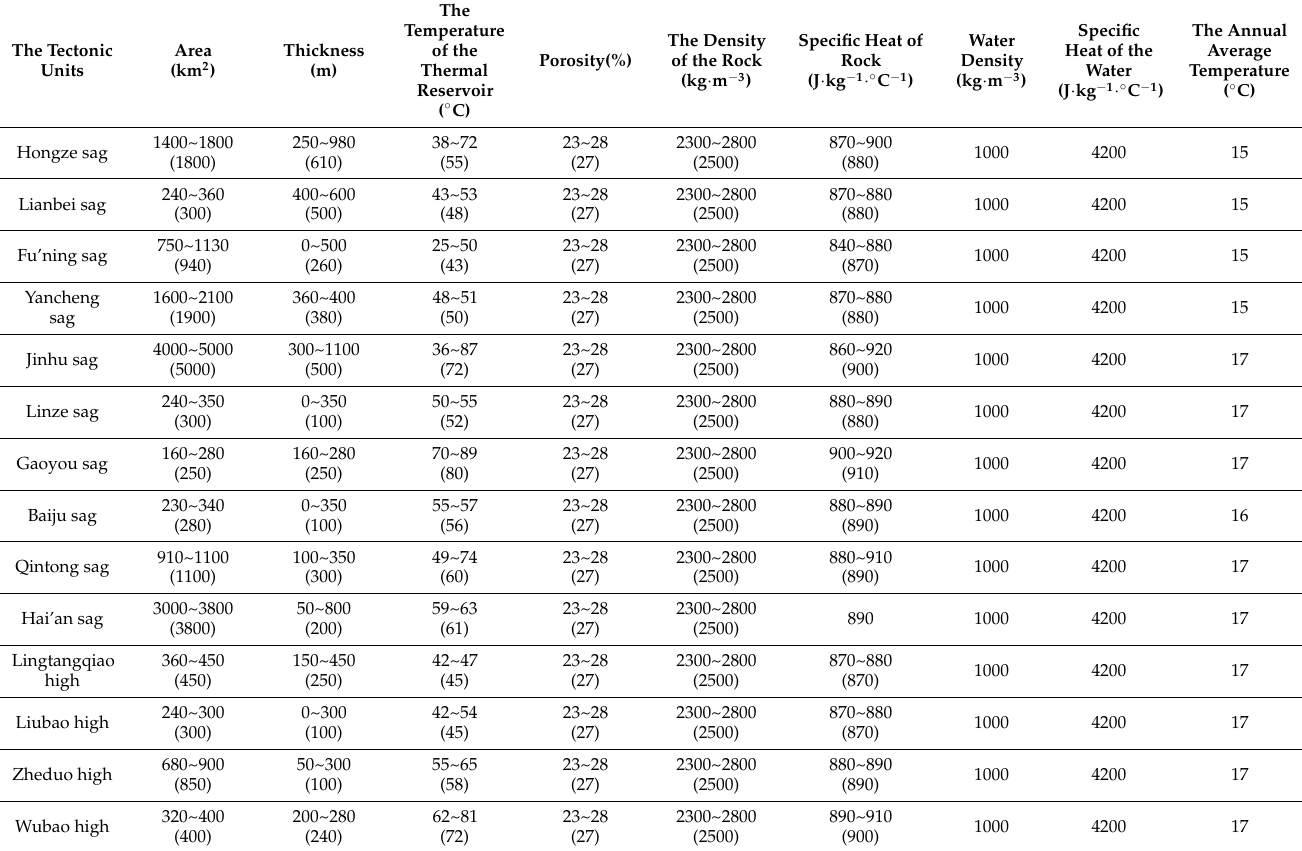
Table 3. Parameters for the Sanduo Formation thermal reservoir.